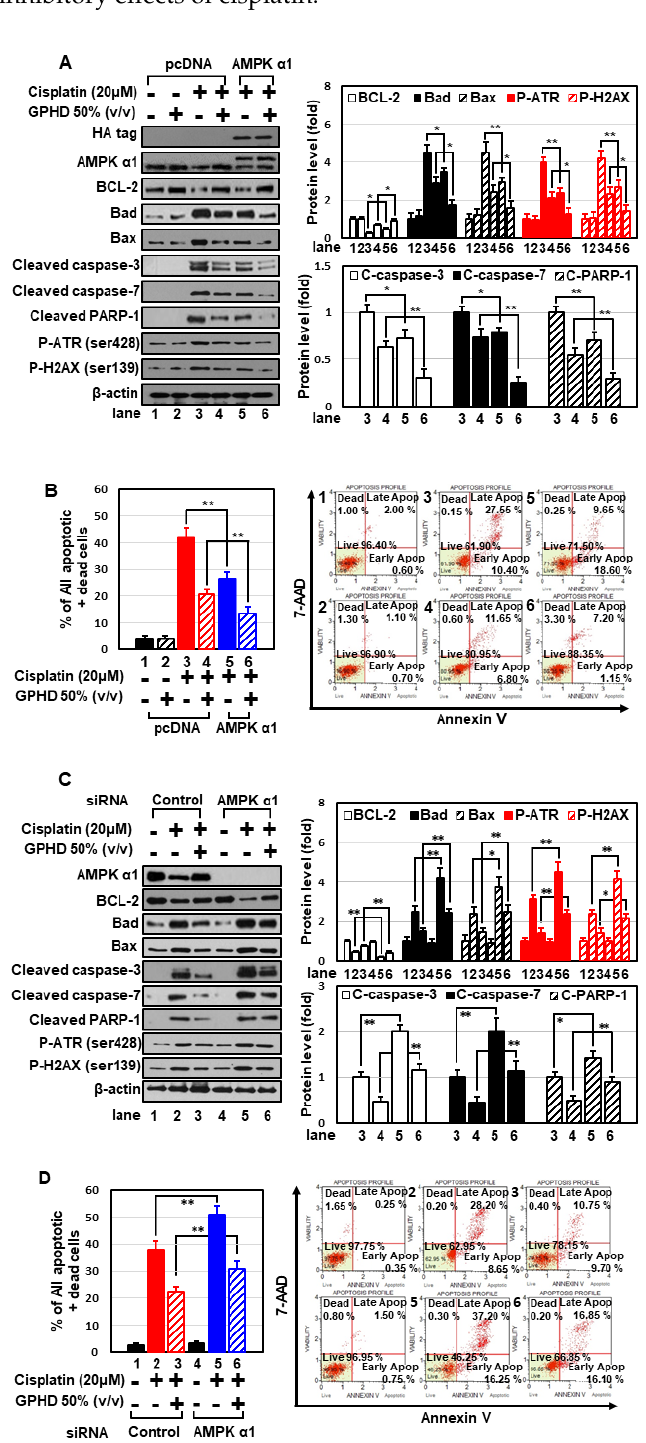
Figure 3. AMPK α 1 plays a critical role in cell survival in the context of cisplatin and GPHD treatment. HEK293 cells were transfected with an expression vector for HA-tagged AMPK α 1 ( A , B ) or siRNA for AMPK α 1 ( C , D ), and then were treated with cisplatin and/or GPHD for 24 h. Apoptosis was analyzed by Western blotting ( A , C ) and FACS analysis ( B , D ). The results shown are representative of the three independent experiments. p -value < 0.05 was considered statistically significant; individual p -values (* p < 0.05; ** p < 0.01) are indicated in